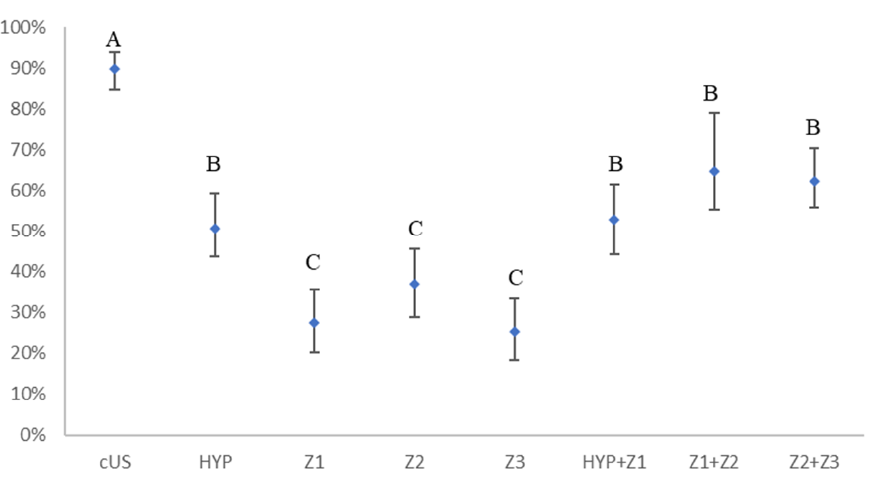
Figure 2. Percentage of true-positive-zones detected with each US scan windows in the entire popu- lation. cUS: complete liver scan through intercostal spaces; HYP: liver scan through hypochondrium; Z1: liver scan from hypochondrium to 11th intercostal space; Z2: liver scan from 10th to 8th intercostal space; Z3: liver scan from 7th to 5th intercostal space, HYP + Z1: sum of scan in HYP and Z1; Z1 + Z2: sum of scan in Z1 and Z2; Z2 + Z3: sum of scan in Z2 and Z3; A, B, C: percentage with the same letter are not significantly different ( p ≤ 0.01).